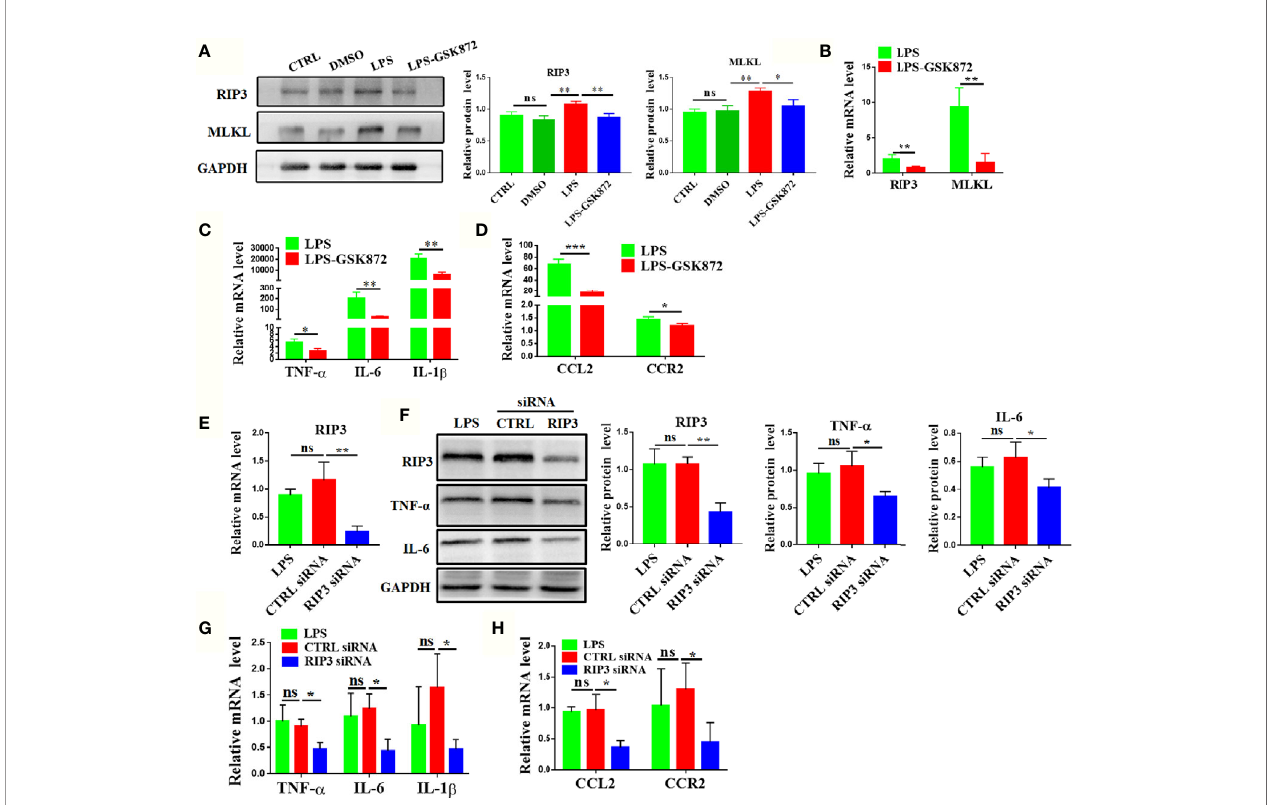
FIGURE 6 | RIP3 signaling pathway regulates the expression of macrophage-related cytokines and chemokines in RAW264.7 cell lines. (A, B) Relative expression of RIP3 and MLKL was inhibited by GSK872. (C, D) Relative expression of TNF- a , IL-6, and IL-1 b (C) , CCL2 and CCR2(D) was down-regulated by GSK872. (E, F) Relative expression of RIP3 was inhibited by RIP3 siRNA and key cytokines such as TNF- a and IL-6 were detected and the relative intensity was quanti fi ed. (G, H) Relative expression of TNF- a , IL-6, and IL-1 b (G) , CCL2 and CCR2(H) was down-regulated by RIP3 siRNA. The data were presented as means ± SD of three independent experiments (Student ’ s t-test, *p < 0.05, **p < 0.01, ***p < 0.001, ns: p >